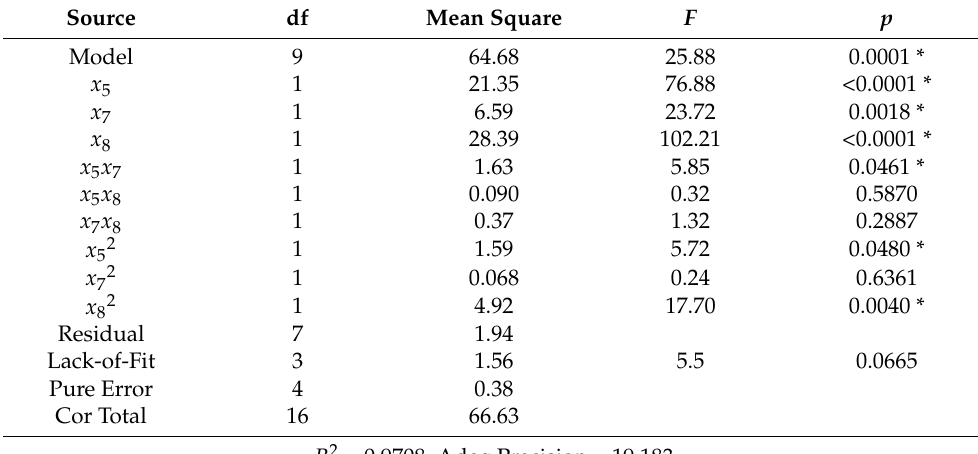
Table 8. ANOVA of the regression model of θ R